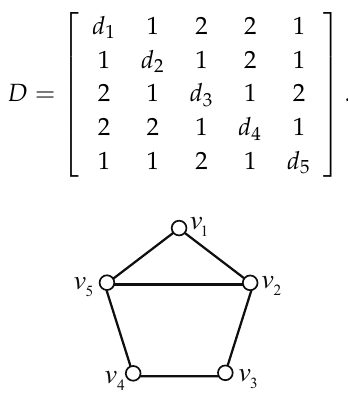
Figure 7. Graph G of d ( G ) = 2, n ( G ) = c ( G ) = 5 and | E ( G ) | = 6.